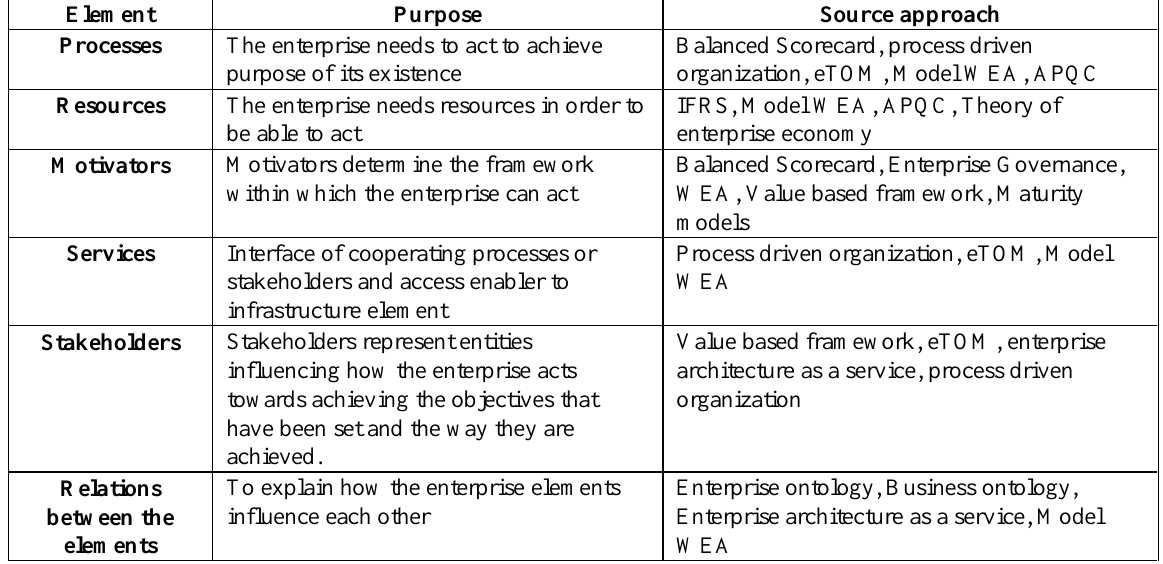
Table 5. Constructs of metamodel of the enterprise